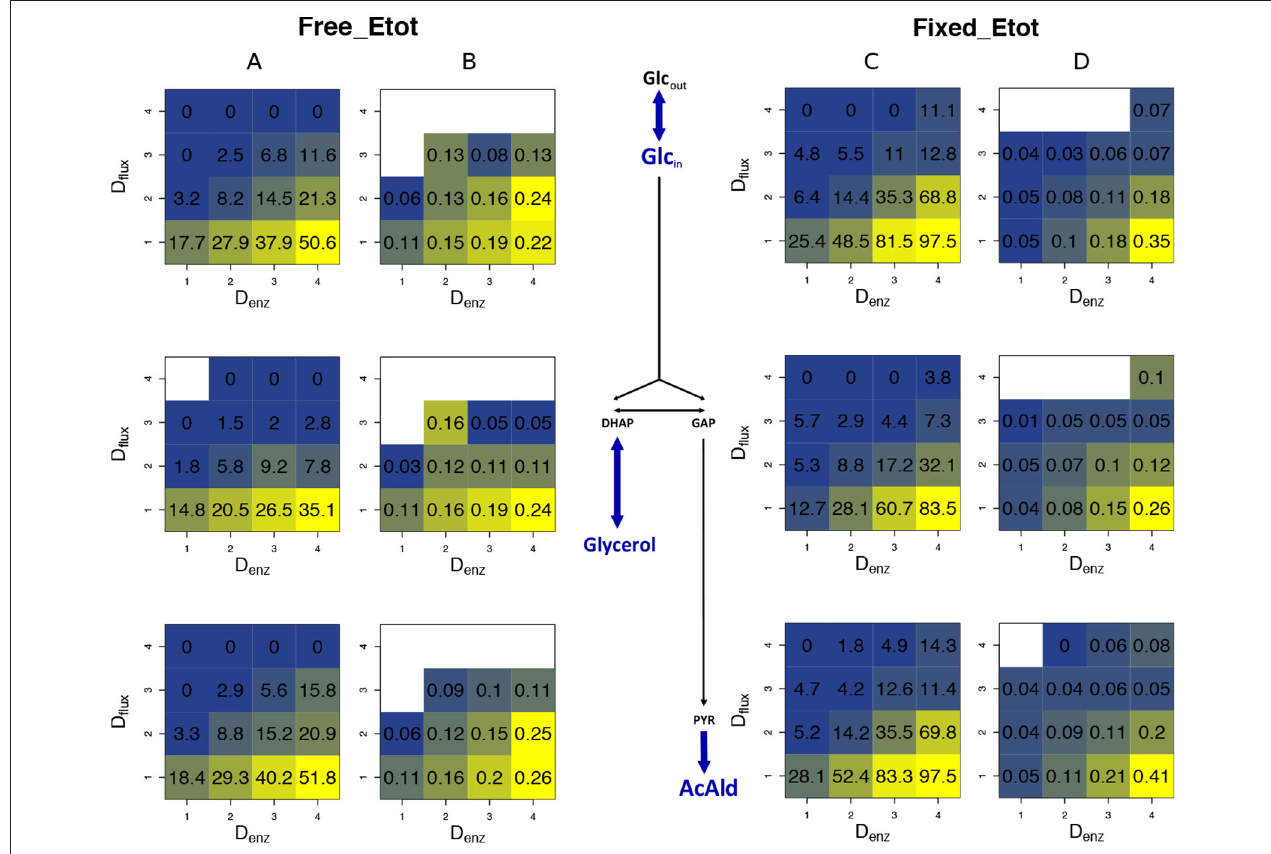
FIGURE 13 | Heterosis predictors in the glycolysis/fermentation network: square grids. (A,B) Square grid with % BPH (A) and H + BP (B) as a function of D enz (x-axis) and D flux (y-axis) for glucose (1st row), glycerol (2nd row) and acetaldehyde (3rd row) when E tot is free. (C,D) Same as (A,B) with fixed E tot